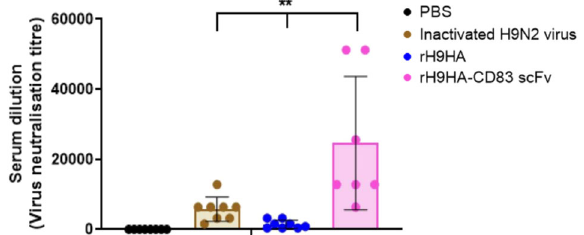
Fig. 7 Virus neutralising antibody titre measured by virus micro- neutralisation (MNT) test. Virus MNT was carried out on day 28 post primary vaccination serum samples (35 μ g dose group). The serum was fi rst inactivated at 56 °C for 30 min and two-fold serum dilutions were made in phosphate-buffered saline. Then, the inactivated serum was incubated with 150 TCID 50 of H9N2 virus (UDL 01/08) for 1 h at 37 °C. The virus-serum mixture was then added onto the MDCK cells and further incubated for 1 h at 37 °C. After 1 h of incubation, the virus-serum mixture was removed from the cells and fresh media containing 2 μ g/ml trypsin was added. The cells were stained with 0.1% crystal violet solution after 3 days. The virus neutralisation titre was expressed as the reciprocal of the highest serum dilution at which virus infection is blocked and the cells survive. Data are presented as mean ± SD and analysed by one-way ANOVA followed by Tukey ’ s multiple comparison test. ** p <